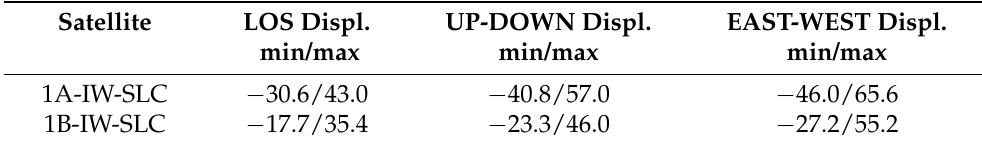
Table 2. Displacement values related to each Sentinel orbit separately, in